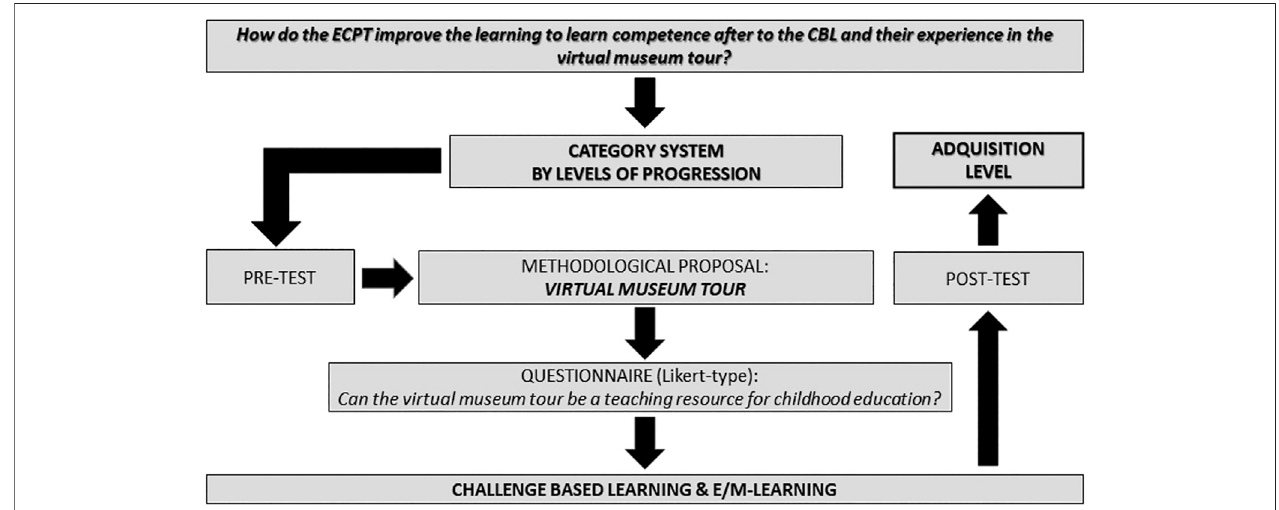
FIGURE 1 | Outline of the investigation.